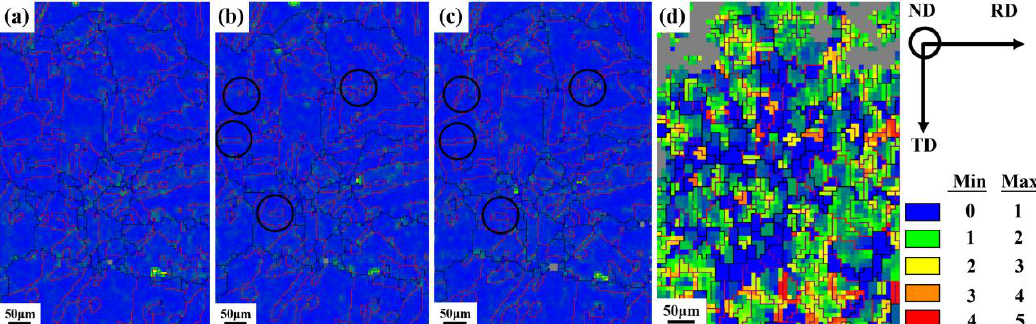
Figure 6. Kernel average misorientation (KAM) map of the same region of the specimen at various true strains: ( a ) 0, ( b ) 0.009, ( c ) 0.024, ( d ) 0.09 (RD: rolling direction, ND: normal direction, and TD: transverse direction).